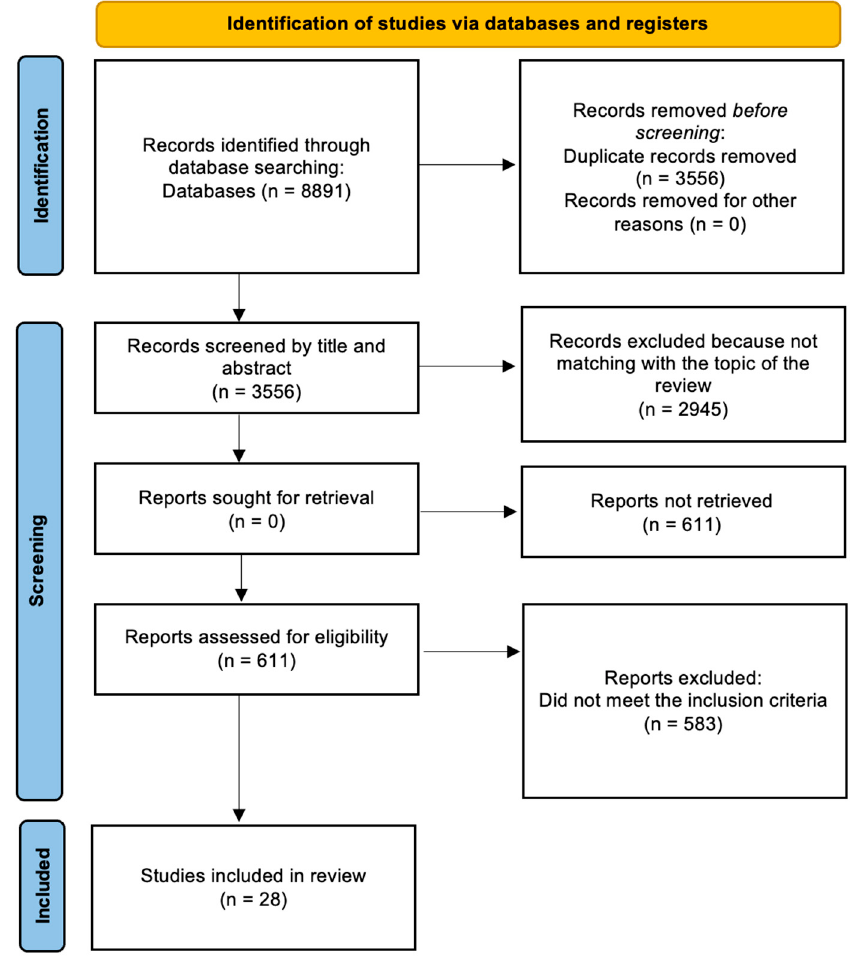
Figure 1. PRISMA (2020) flow diagram.